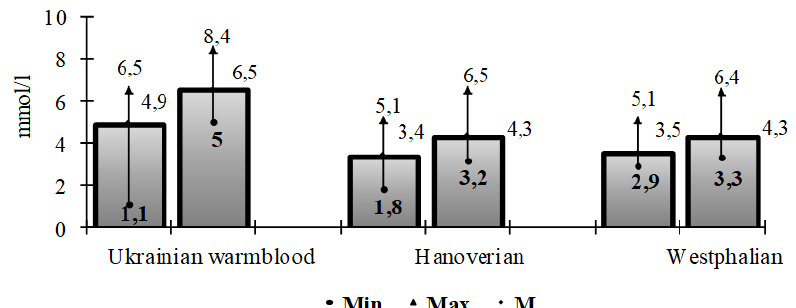
Fig. 1. The content of lactate in blood serum of sports horses before and after